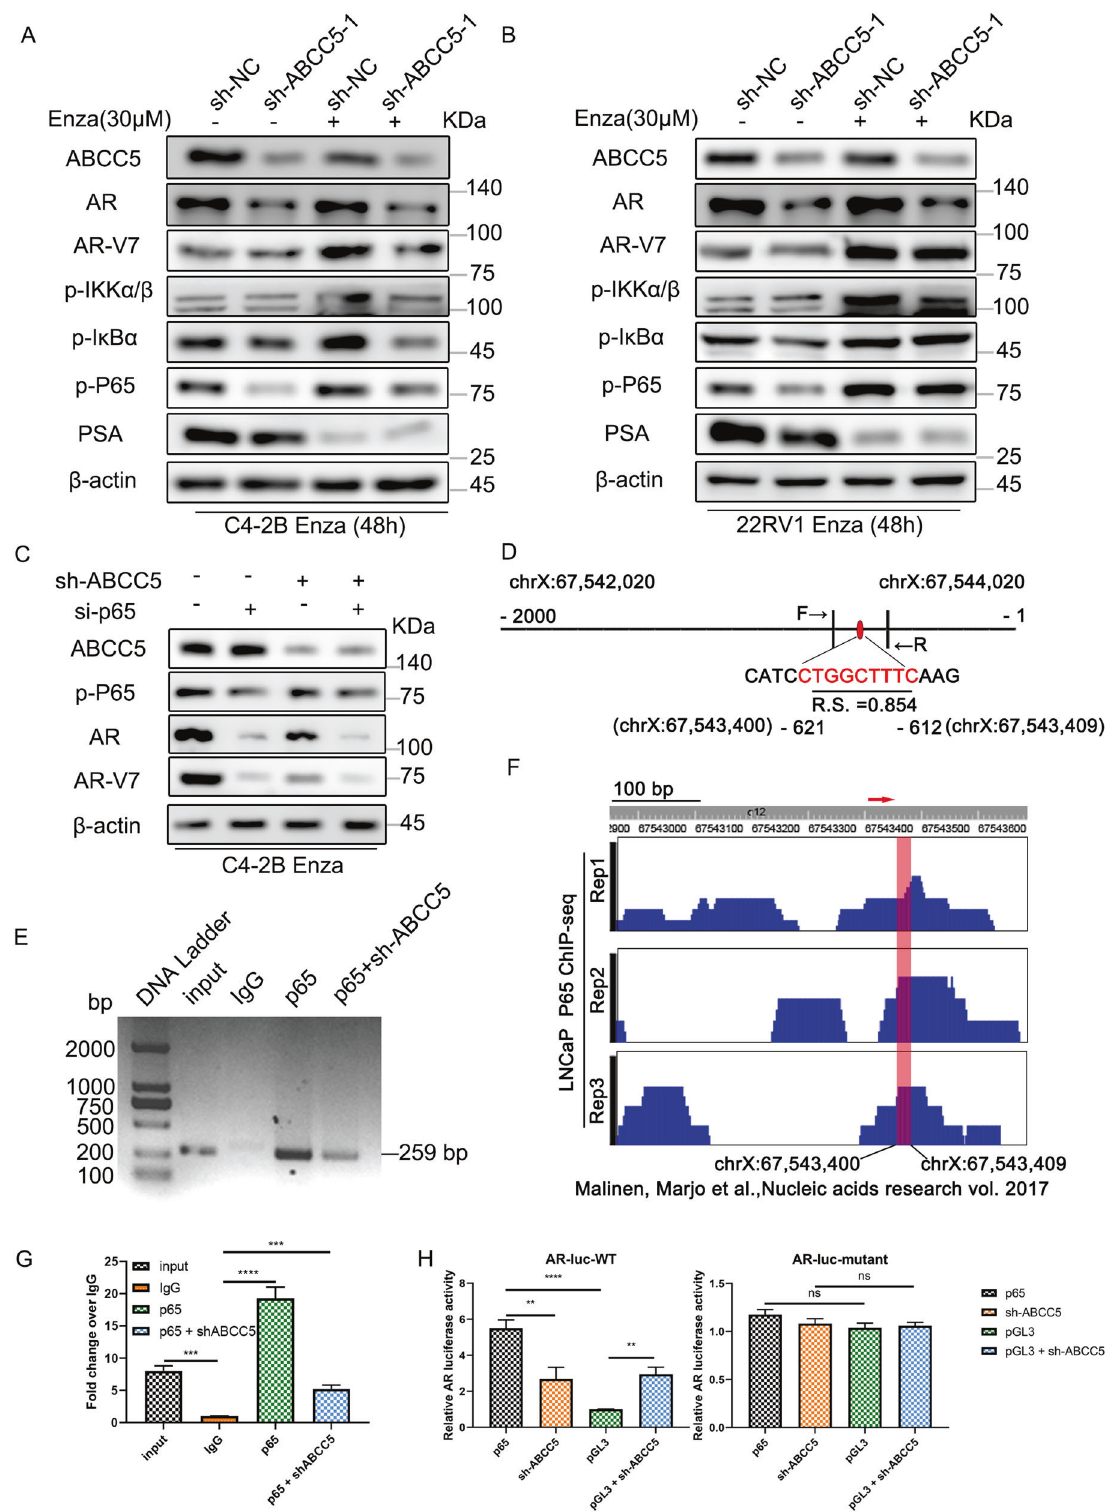
To investigate whether ABCC5 regulates PCa cells in an NF- κ B pathway-dependent manner, PCa cells with ABCC5 knockdown were treated with Asatone, an agonist of NF- κ B [28], to rescue NF- κ B pathway-speci fi c activation in C4-2B Enza and 22RV1 Enza cells. We found that Asatone (5 µM) reversed ABCC5